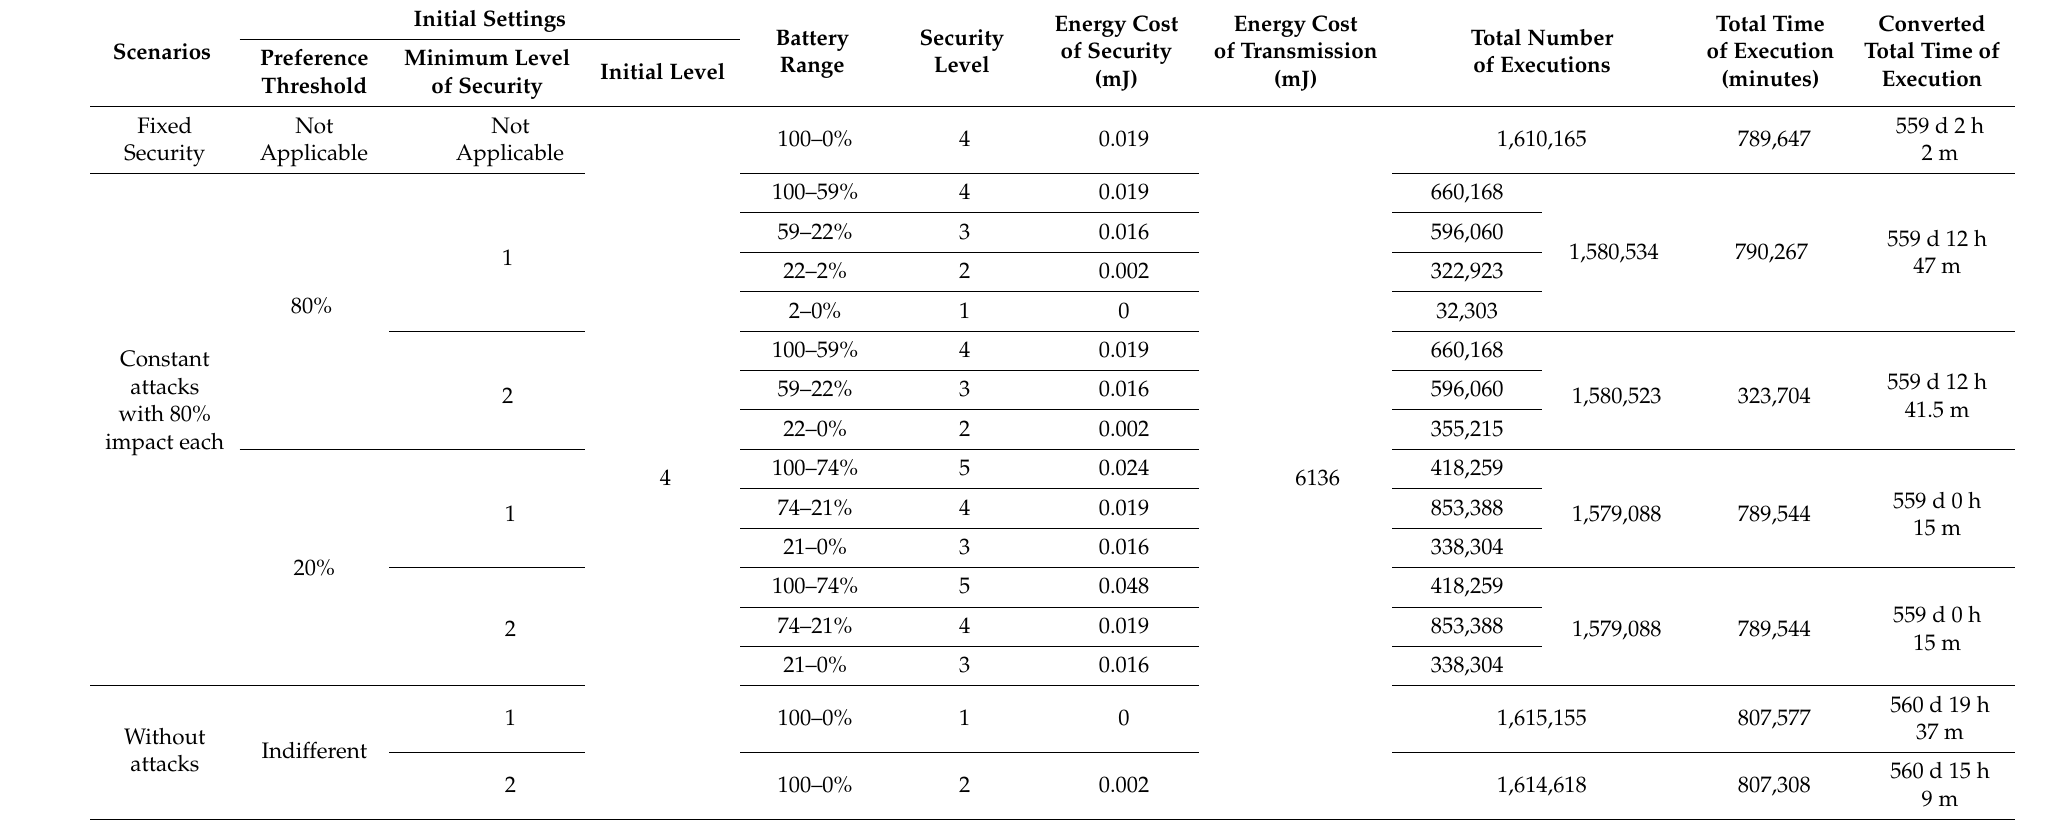
Table 8. Results for the analytical evaluation of the Controller in the context of LoRaWAN, + (number of cycles and total time for